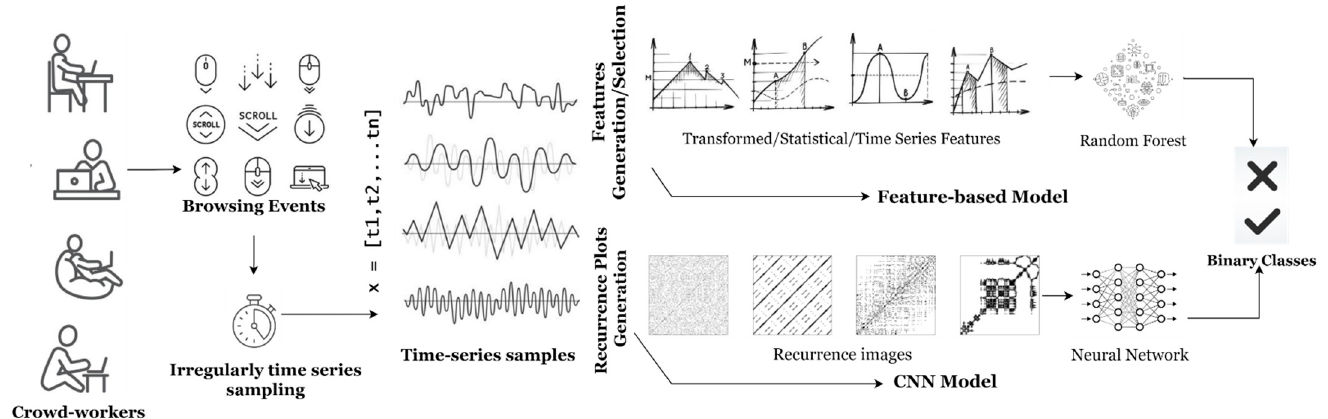
Figure 1. The proposed models.